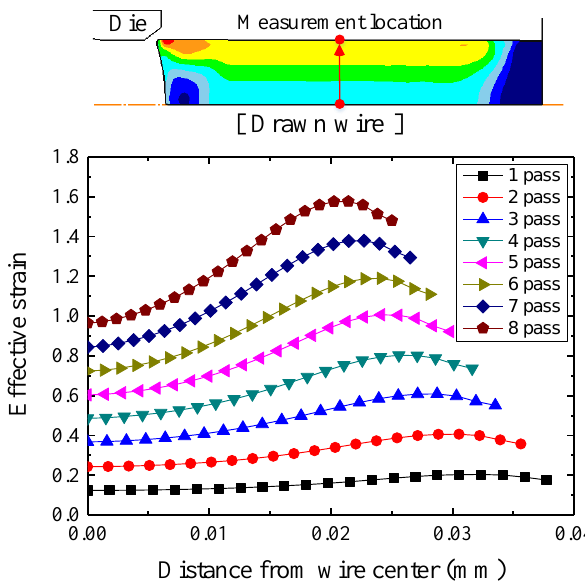
Figure 8. Distribution of the effective stain in the drawn wire.